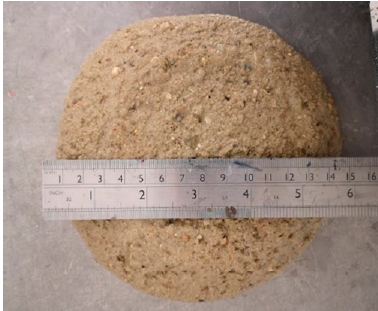
Figure 3. The flow diameter of a CGM with a high amount of GGBS (G91F00M09R00). Table 3. Main results.